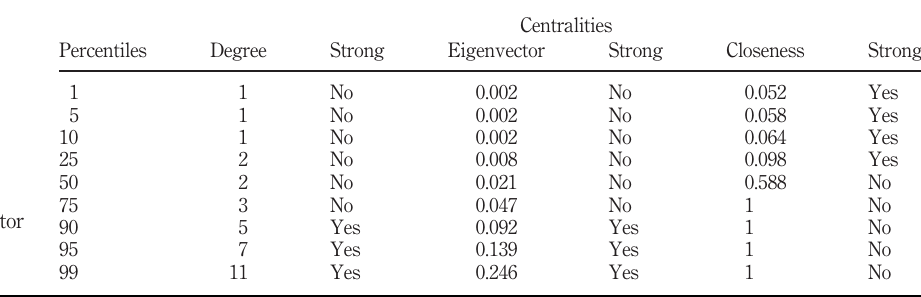
Table IV. Distributions of degree, eigenvector and closeness